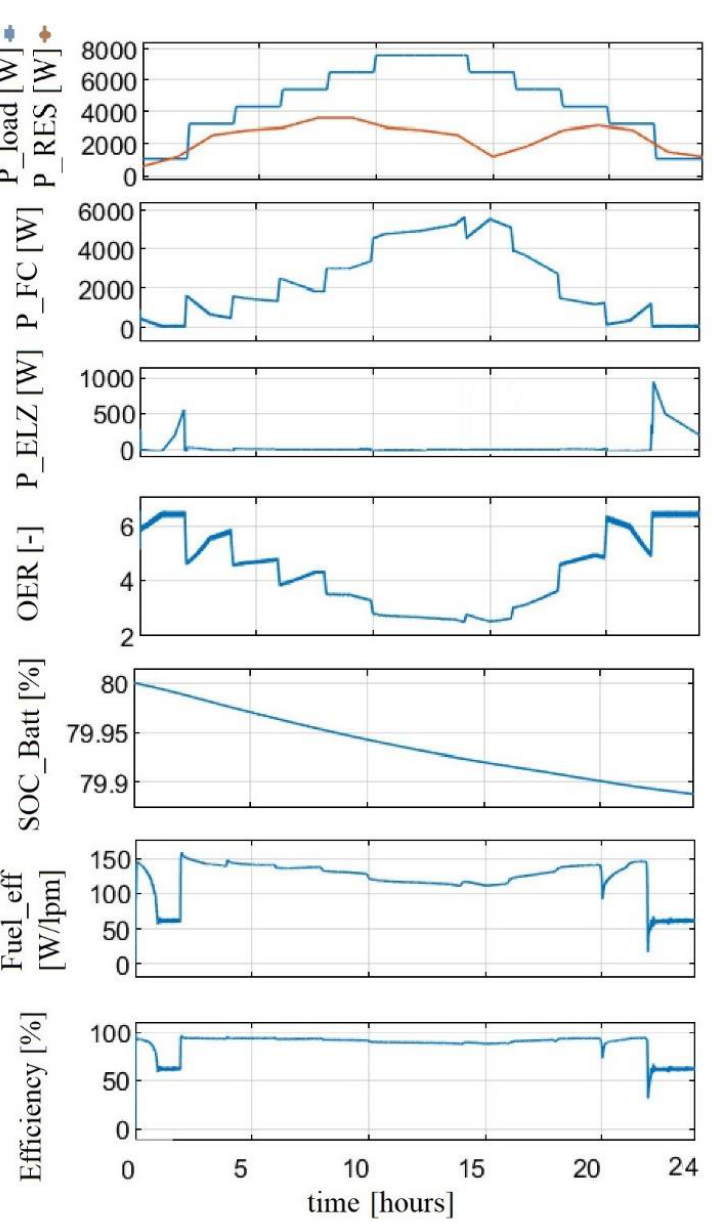
Figure 4. Operation of the charging station based on the FC/ELZ/RES DCmG when p RES < p Load . Thus, the ELZ was powered with the excess power given by (18), which is shown in Plot 3 of Figure 5. Additionally, it is worth mentioning that the SOC Batt remains almost constant (see Plot 5 in Figure 5).